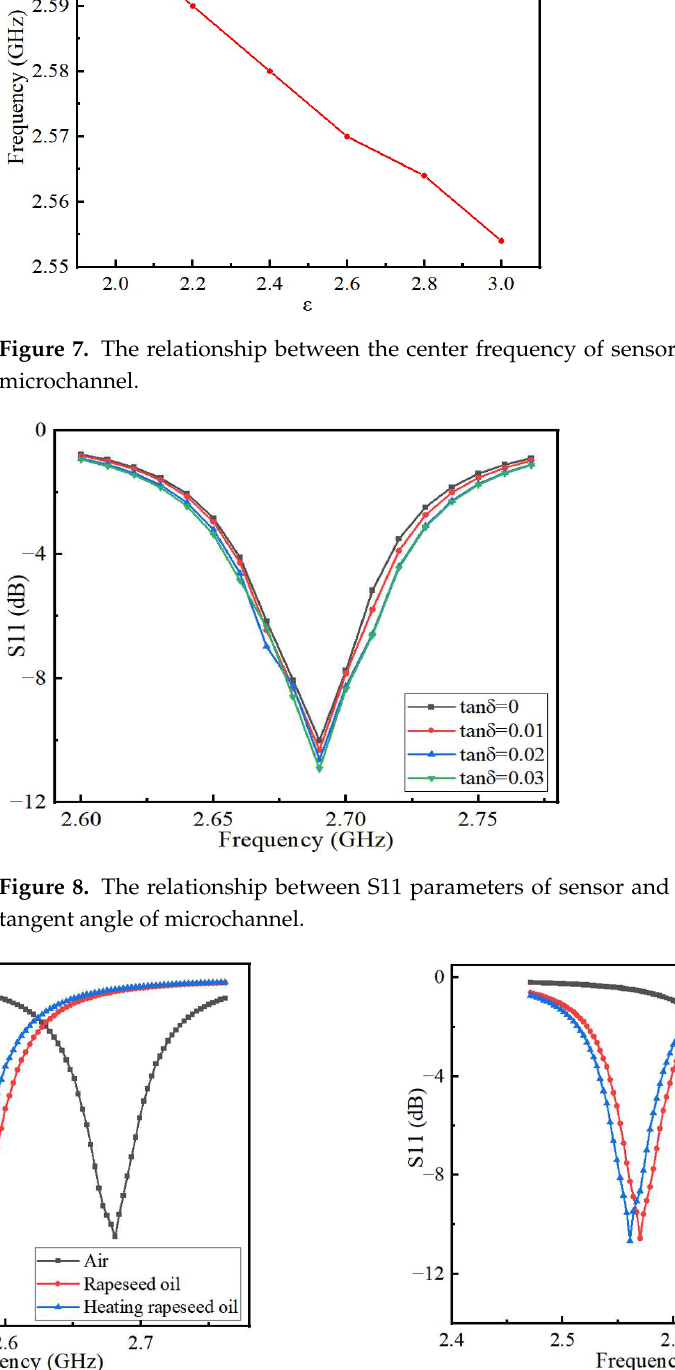
Figure 7. The relationship between the center frequency of sensor and the dielectric constant of mi- crochannel.